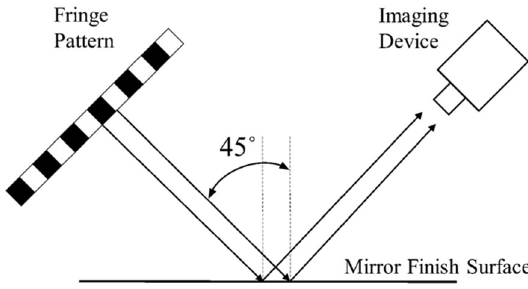
Figure 3. Schematic illustration of the surface-measurement system.